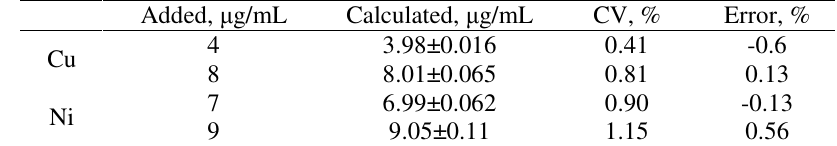
Table 4. Determination of nickel (9,7 µ g/mL) in presence of copper (6 µ g/mL) and copper (4, 8 µ g/mL) in presence of nickel (7 µ g/mL), in artificial samples(n=4)